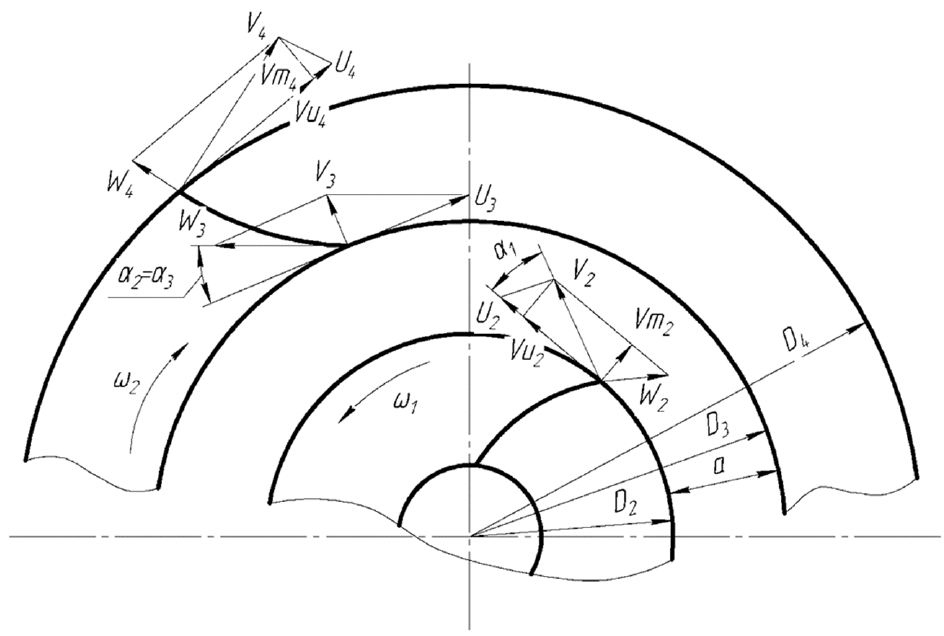
Figure 1. Flow kinematics in a centrifugal counter-rotating stage.